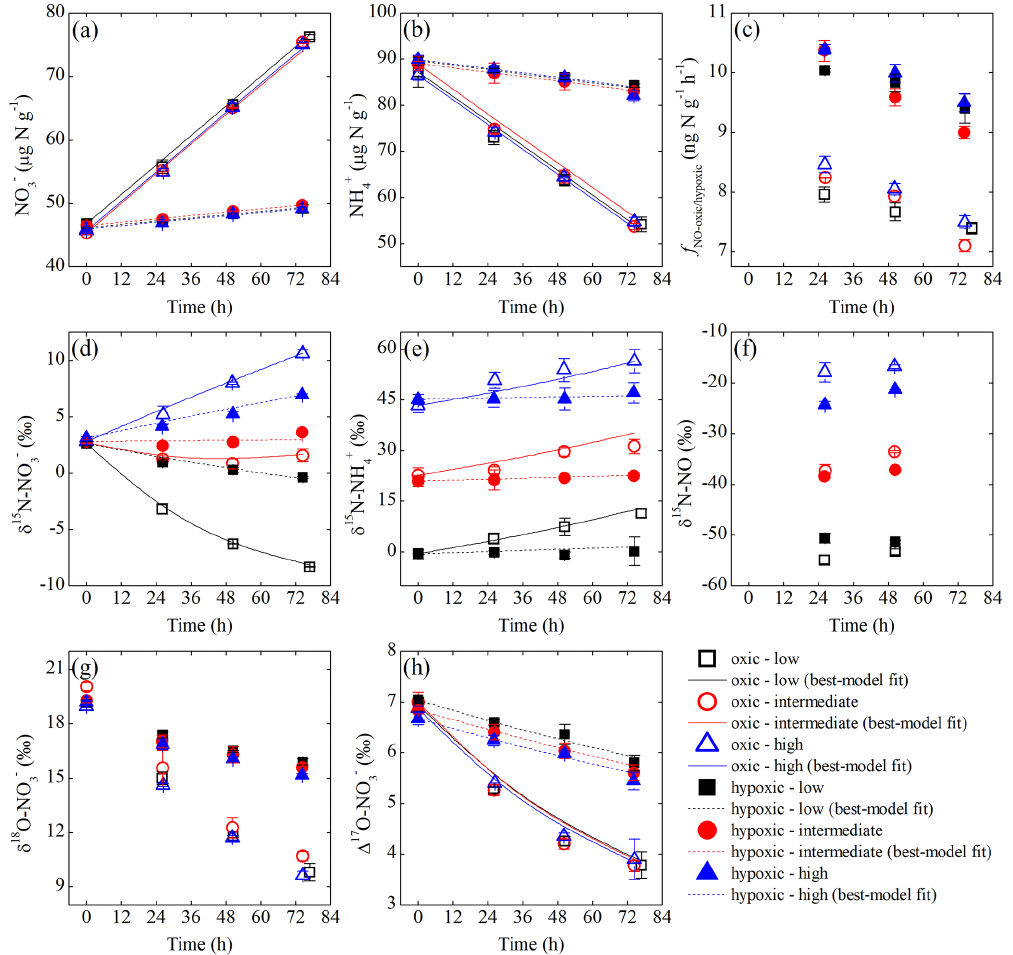
Figure 3. Measured and modeled concentrations of NO − and NO (f) ; and δ 18 O (g) and (cid:49) 17 O (h) of NO − hypoxic (solid symbols)